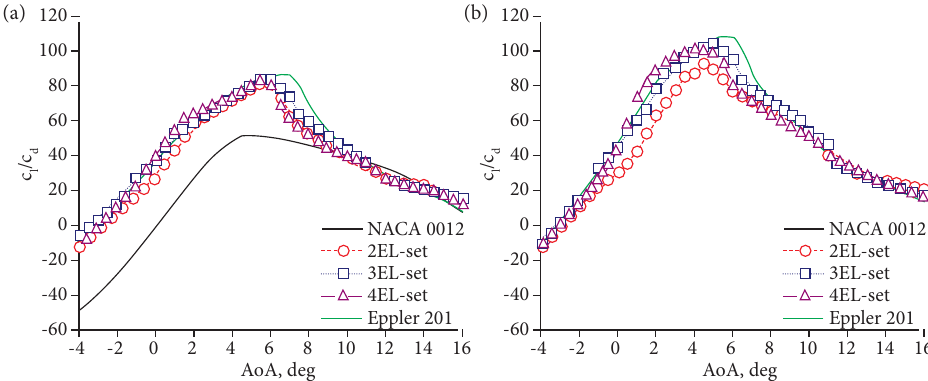
Figure 7. Aerodynamic efficiency of morphed airfoil groups with target airfoil. (a) Re = 2.5 × 10 5 ; (b) Re = 4.8 × 10 5 .